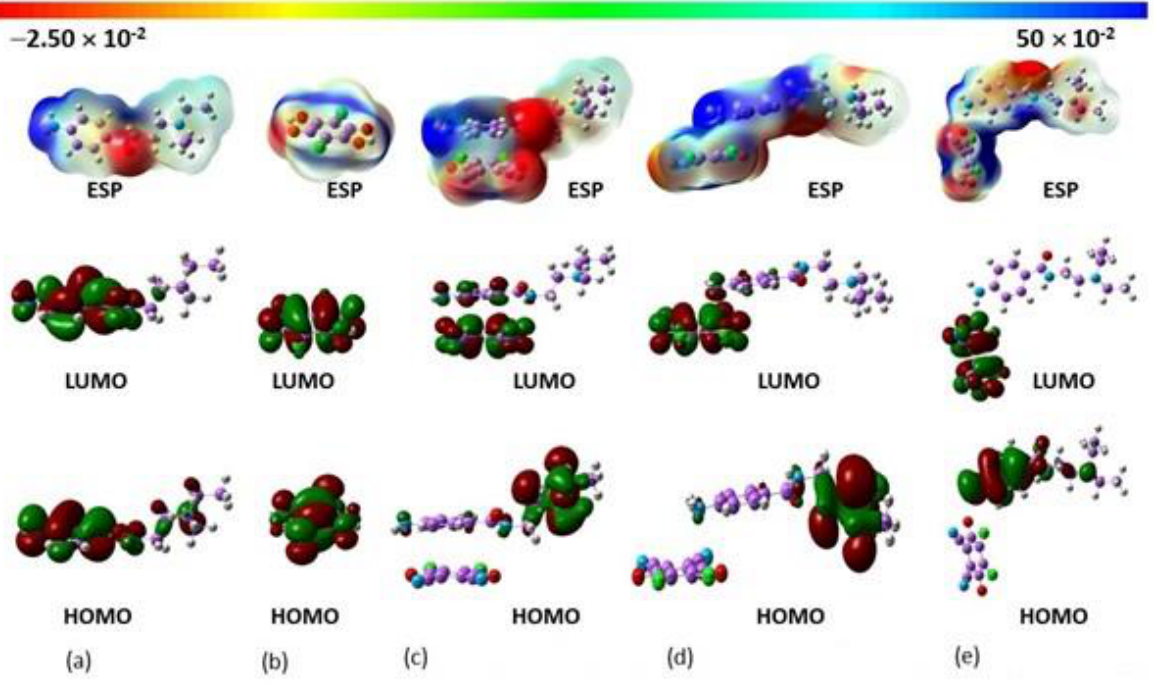
Figure 13. Molecular electrostatic potential (MEP) maps of HOMO and LUMO structures of PA, DDQ, and their 1:1 complex: ( a ) PA; ( b ) DDQ; ( c ) face-to-face I fashion complex of PA with DDQ; ( d ) face-to-face II fashion complex of PA complex with DDQ; and ( e ) edge-to-edge fashion complex of PA with DDQ at the ωB97XD/6 -311++G(2d,p) level of theory in acetonitrile solvent system. Table 5. HOMO- LUMO gap (Δ E gap ), ionization potential (IP), electron affinity (EA), electronegativity (χ), chemical potential (μ), hardness (η), softness (S), electrophilicity index (ω), dipole moments (dm), and polarizability (α) of the PA, ChA, DDQ , and their complexes at the ω B97XD/6 − 311++G(d,2p) level of theory in acetonitrile solvent.